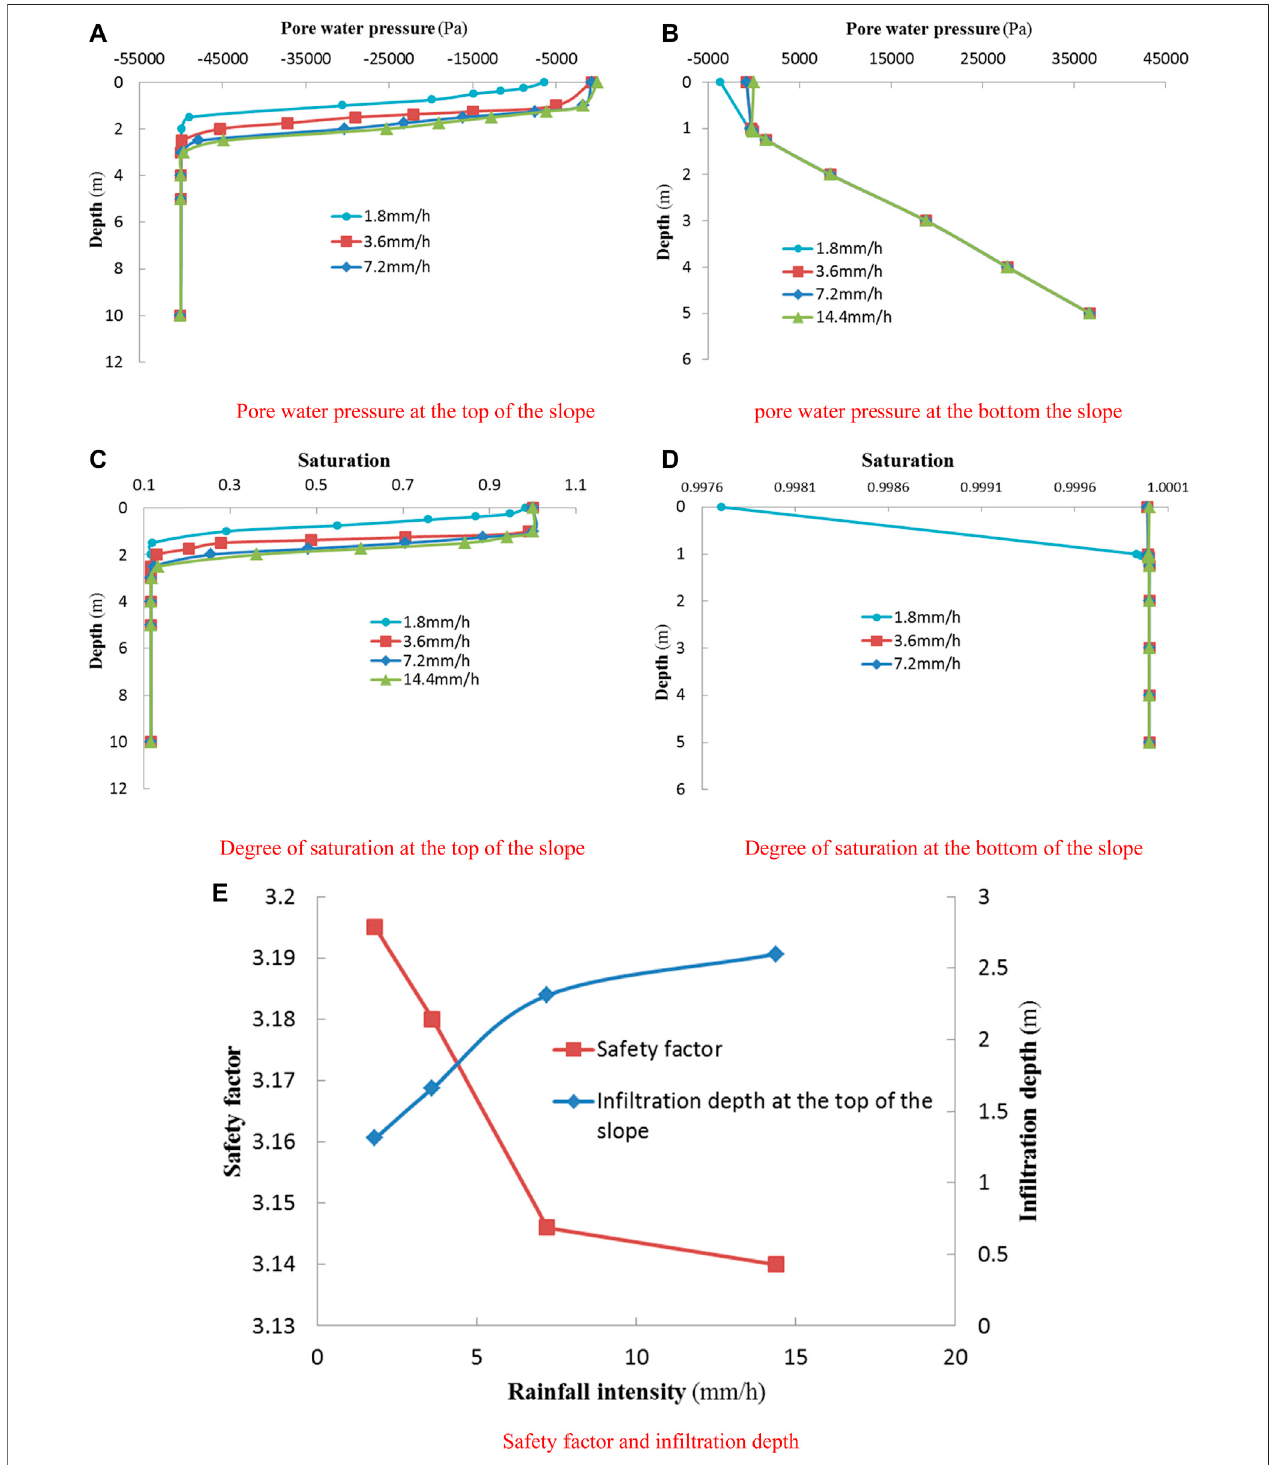
FIGURE10| Distributionofporewaterpressureanddegreeofsaturationunderdifferentrainfallintensities: (A) Porewaterpressureatthetopoftheslope, (B) Pore water pressure at the bottom of the slope, (C) Degree of saturation at the top of the slope, (D) Degree of saturation at the bottom of the slope, (E) Safety factor and in fi ltration depth.